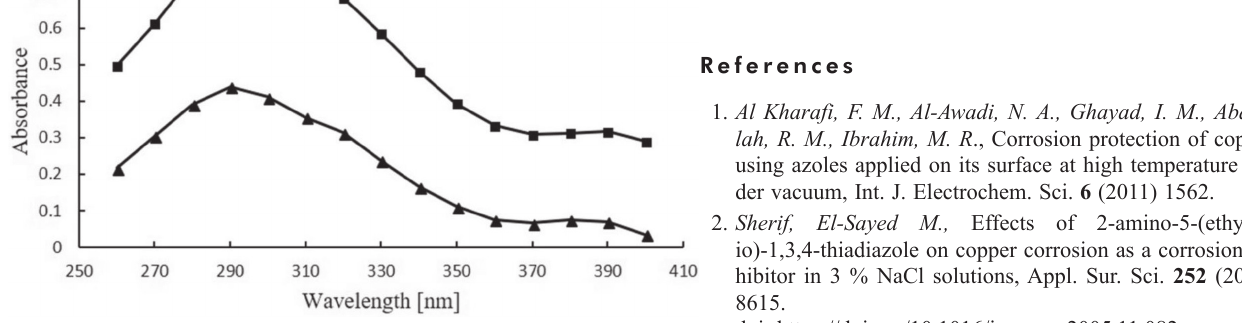
Fig. 6 – UV-Visible spectra of test solution with propolis ex- tract (3500 mg dm –3 ): before immersion (■), and after 48 hours immersion (▲) of copper samples in